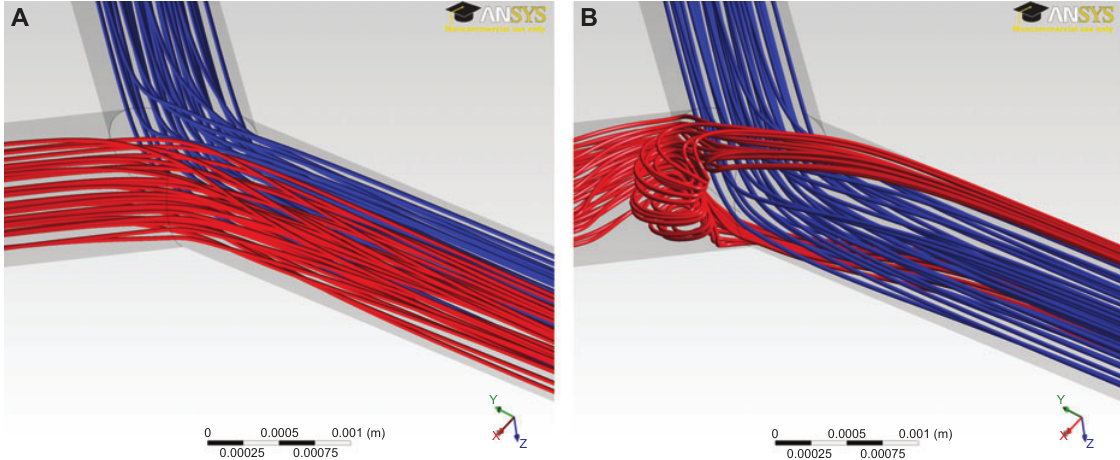
= 0.03 g/s and m ˙ = 0.000283 g/s. Red streamlines show trajectories based on the veloc- Init Init